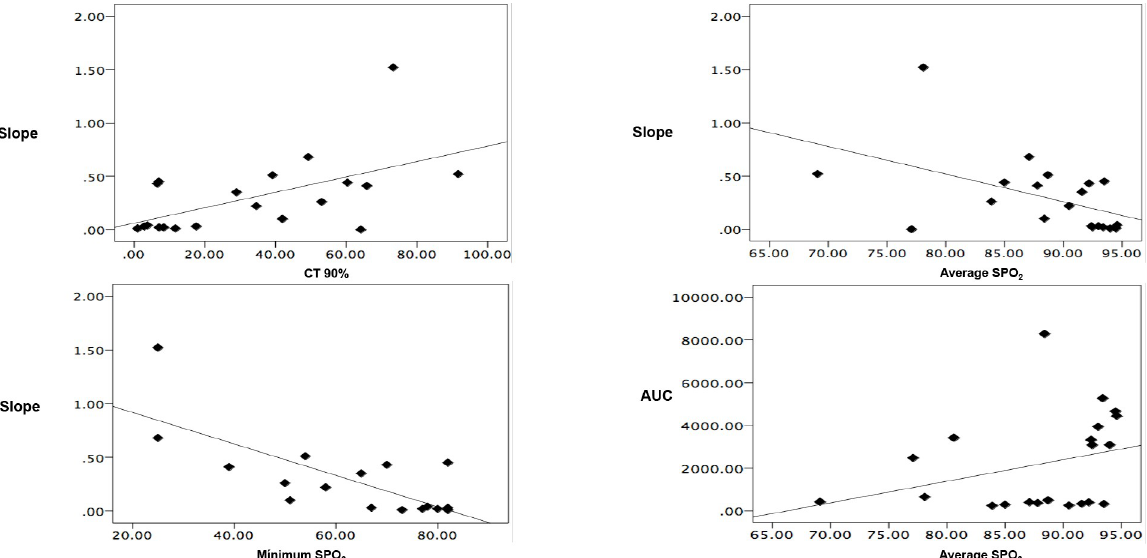
Fig 1. There is a relationship between the oximetric patterns of non-hypertensive OSA patients and their endothelial function. AUC: Area under the curve (perfusion units). � p < 0.05.